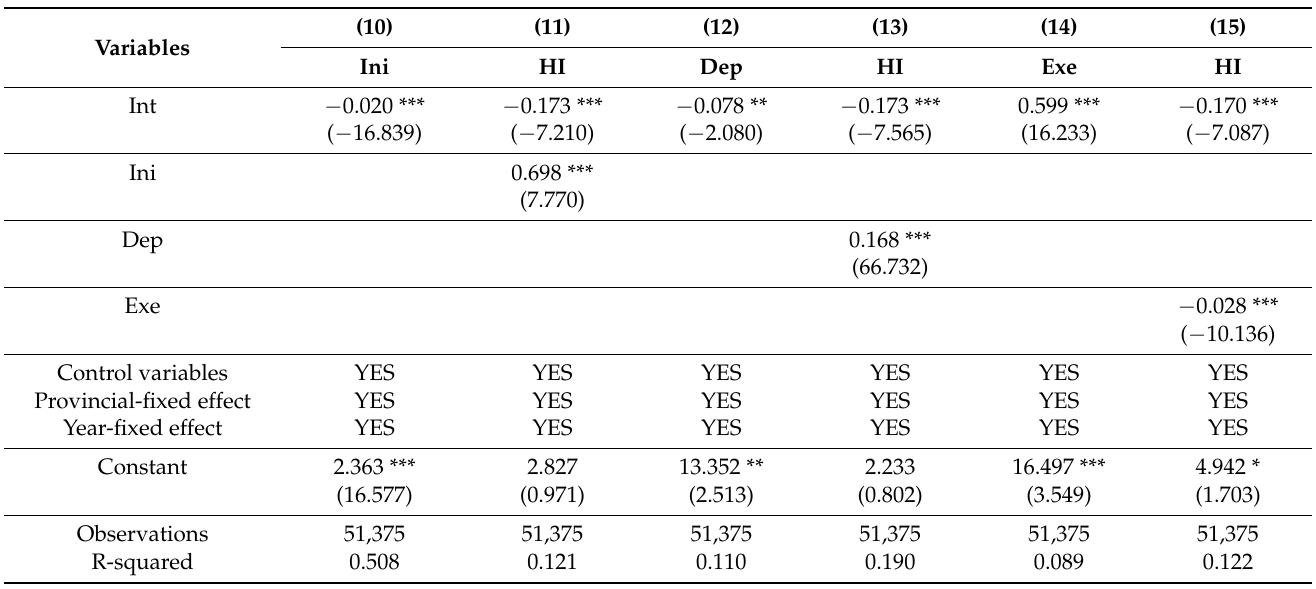
Table 4. Mechanism test